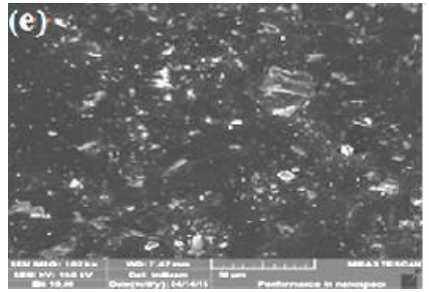
Figure 5. SEM micrographs of ( a ) PS- b -(PE- r -B)- b -PS- g -MA and composites with ( b ) 2; ( c ) 6; ( d ) 10; and ( e ) 14 wt % Cu–Al 2 O 3 .